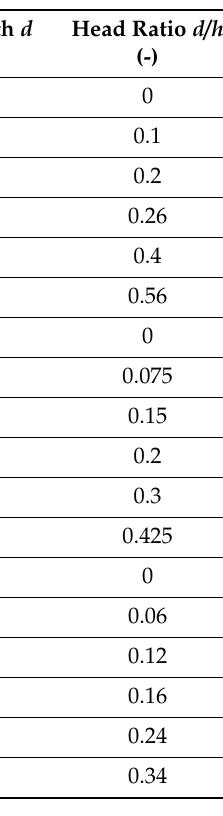
Table 1. List of hydrodynamic tests (no pipe).